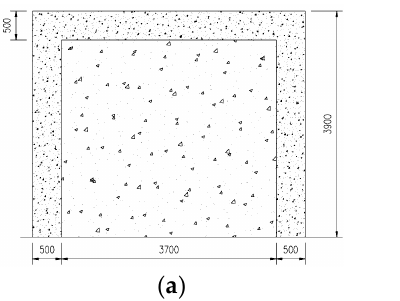
Figure 4. The related design diagrams of GJ-3. ( a ) Ordinary reinforced concrete shear wall; ( b ) reinforcement diagram of the beam and column of the shear wall.